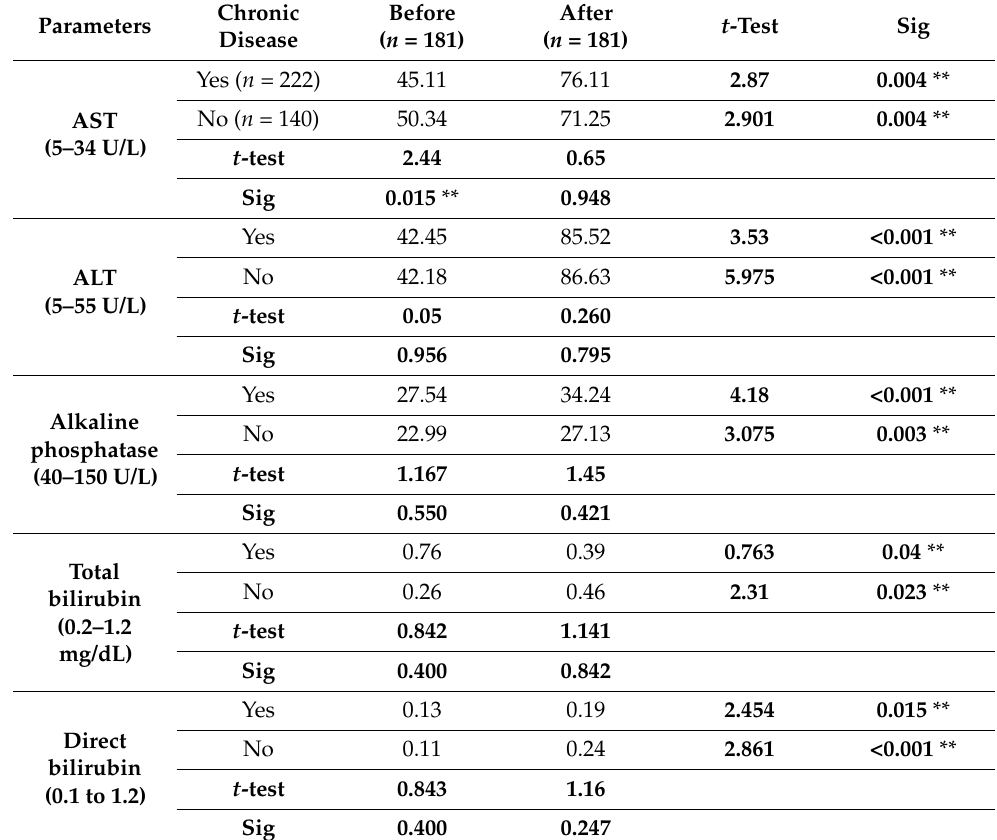
Table 6. A chronic disease with inpatients treated and non-treated with